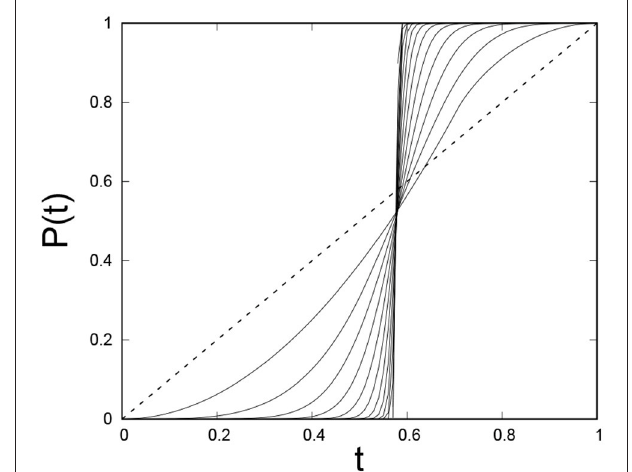
FIGURE 6 | Evolution of the cumulative threshold probability under the real space renormalization group iteration is shown where lines represent the P ( t ) values for different renormalization steps. The initial number of fibers was N 2 15 . A uniform threshold distribution on the unit interval is assumed, so = t (dotted line) at the initial stage. that the cumulative probability is P ( t ) = Averages are taken over 10 6